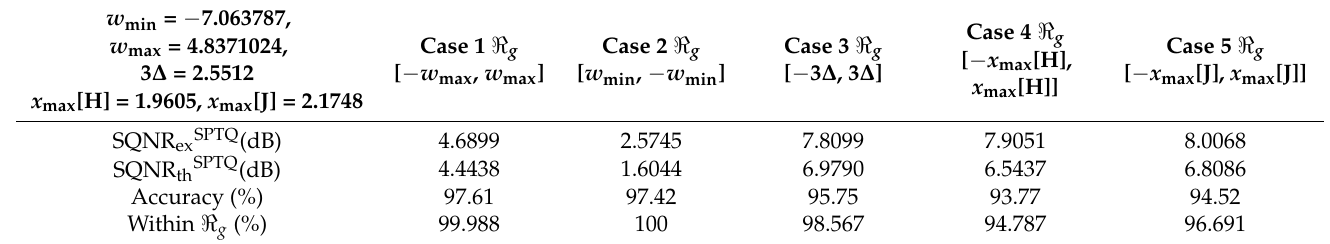
Table 3. SQNR and QNN model’s accuracy for MLP trained on MNIST dataset: different SPTQ designs for R = 2 bit/sample.